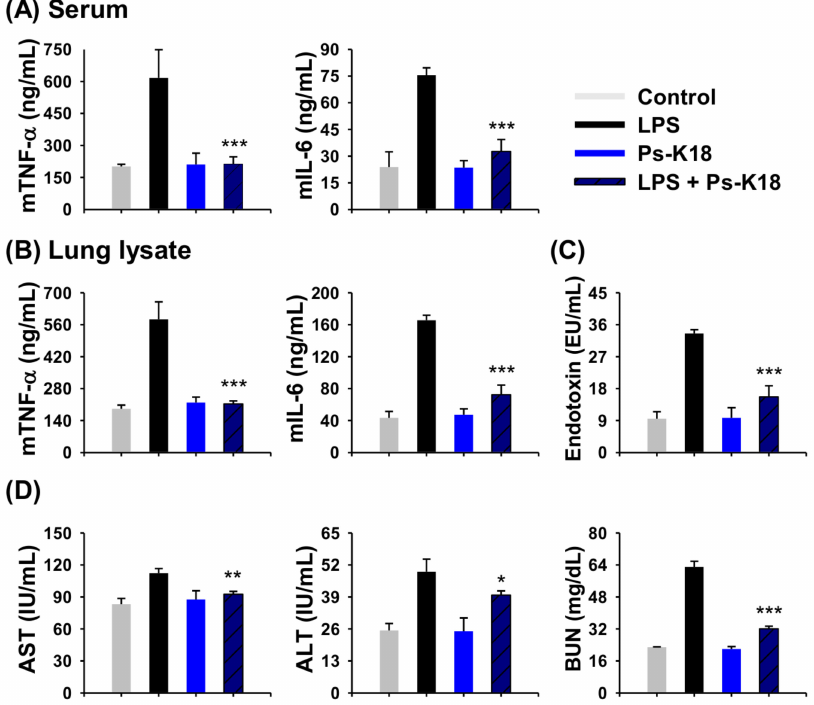
Figure 5. E ff ects of Ps-K18 on LPS-induced endotoxemia mouse model. ( A ) Inhibition of cytokine production (mTNF- α and mIL-6) in the serum. ( B ) Inhibition of cytokine production (mTNF- α and mIL-6) in lung lysates. ( C ) Reduction of LPS endotoxin by Ps-K18 in serum of the LPS-induced sepsis model. ( D ) AST, ALT, and BUN levels in the mouse septic shock model induced by LPS. BALB / c mice were pre-treated with 1 mg / kg of peptide, followed by intraperitoneal injection with 15 mg / kg of LPS. Data are presented as means ± standard errors of the mean (* p < 0.05; ** p < 0.01; *** p < 0.001; ns. represents no significance) compared to LPS-injected group. All measurements were obtained five